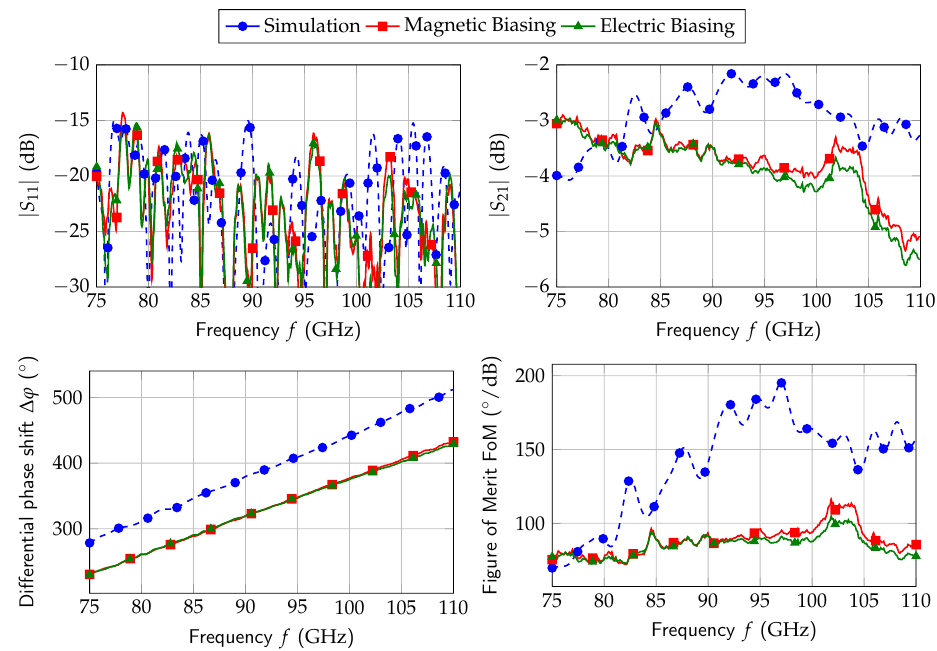
Figure 25. Measured (solid) and simulated (dashed) results of the step-index phase shifter. For simplification, S-parameter plots show perpendicular orientation only.